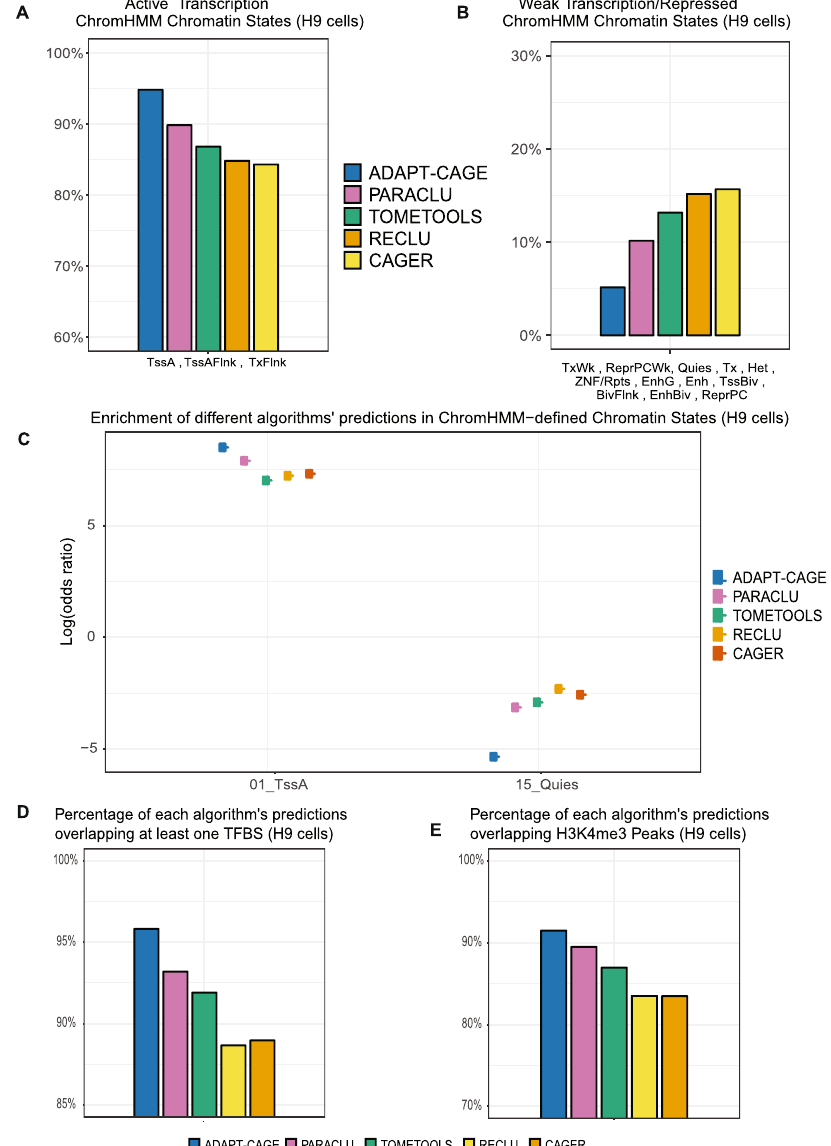
Figure 3. Evaluating algorithms’ performance on experimental data in H9 cells. Percentage of each algorithm’s predictions uniquely overlapping ChromHMM-derived chromatin states based on the core-15 model in H9 cells. Chromatin states were aggregated in two groups according to levels of chromatin/transcriptional activity. Active ( A ) and weaker ( B ) transcription states. ( C ) Enrichment (odds ratio in logarithmic scale) of algorithms’ prediction in the two most orthogonal ChromHMM-derived chromatin states (TssA and Quies). Percentage of each algorithm’s predictions overlapping at least one transcription factor binding site ( D ) and H3K4me3 ( E ) ChIP-Seq derived